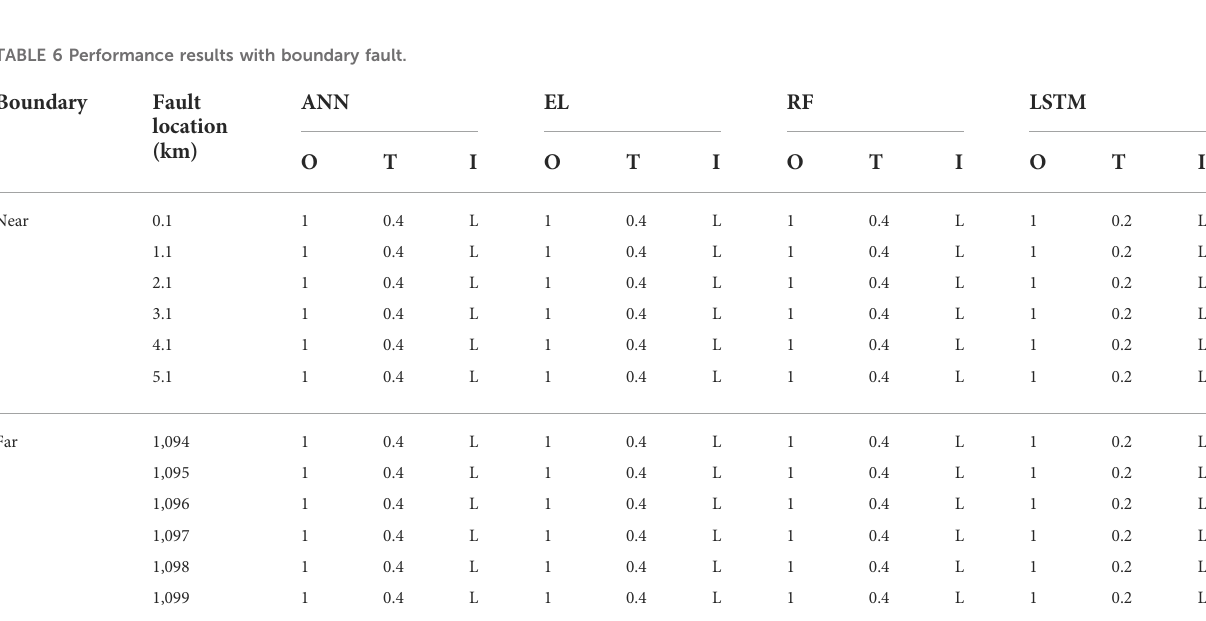
0.2 ms for all the tested fault cases using the LSTM method. The other three methods have a fault detection time of 0.4 ms. All the faults are also identi fi ed correctly as transmission line faults using all methods. Figure 8 shows the inputs and outputs during the P2G fault at 1,000 km with R = 0 Ω at 2 ms. Moreover, Figures 8A,B show the input features of pole 1 and pole 2 during the transmission line fault, respectively. Figures 8C – E show the output that becomes “ 1 ” at 2.4 ms after the occurrence of fault at 2 ms showing a transmission line fault for ANN, RF,